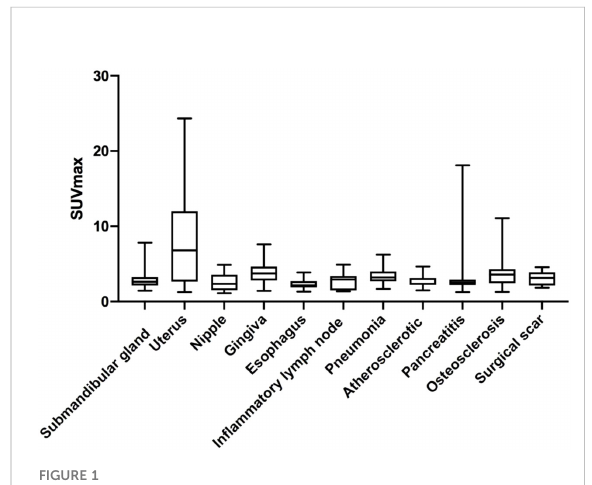
FIGURE 1 SUV max of non-tumoral tracer uptake